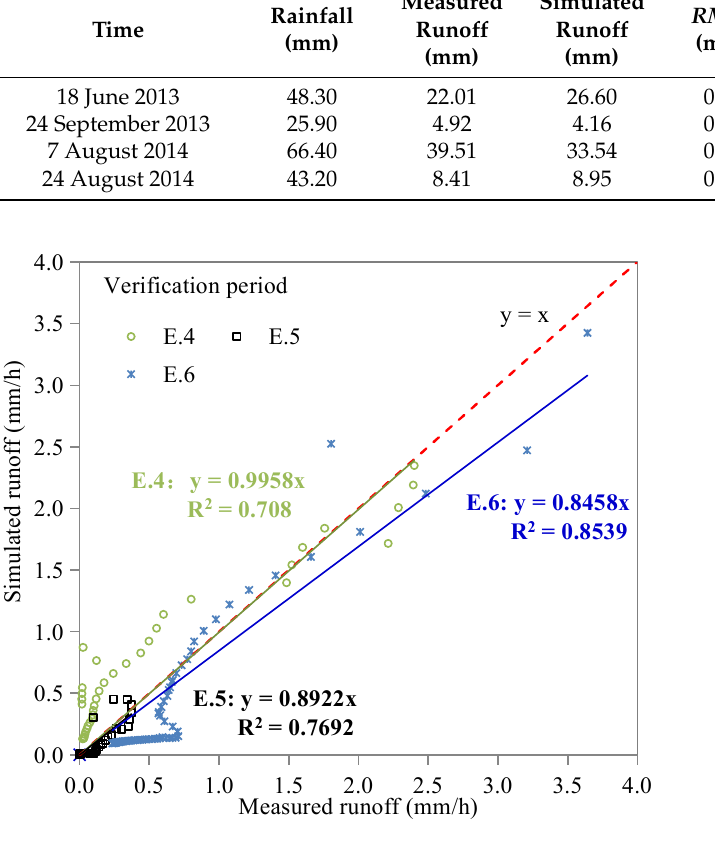
Figure 8. Scatter plot of simulated and measured runoff values in the verification period.